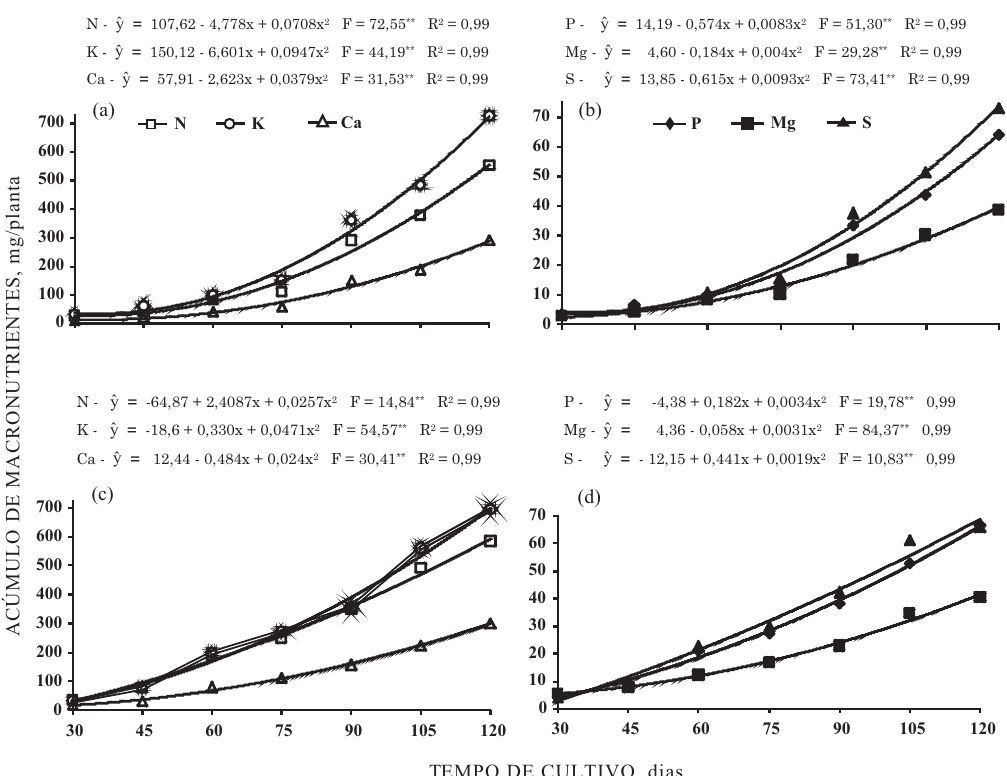
Figura 1. Efeito do tempo de cultivo no acúmulo de macronutrientes das mudas de goiabeira cultivar Paluma (a e b) e Século XXI (c e d), cultivadas em solução nutritiva durante 120 dias após o transplantio (médias de quatro